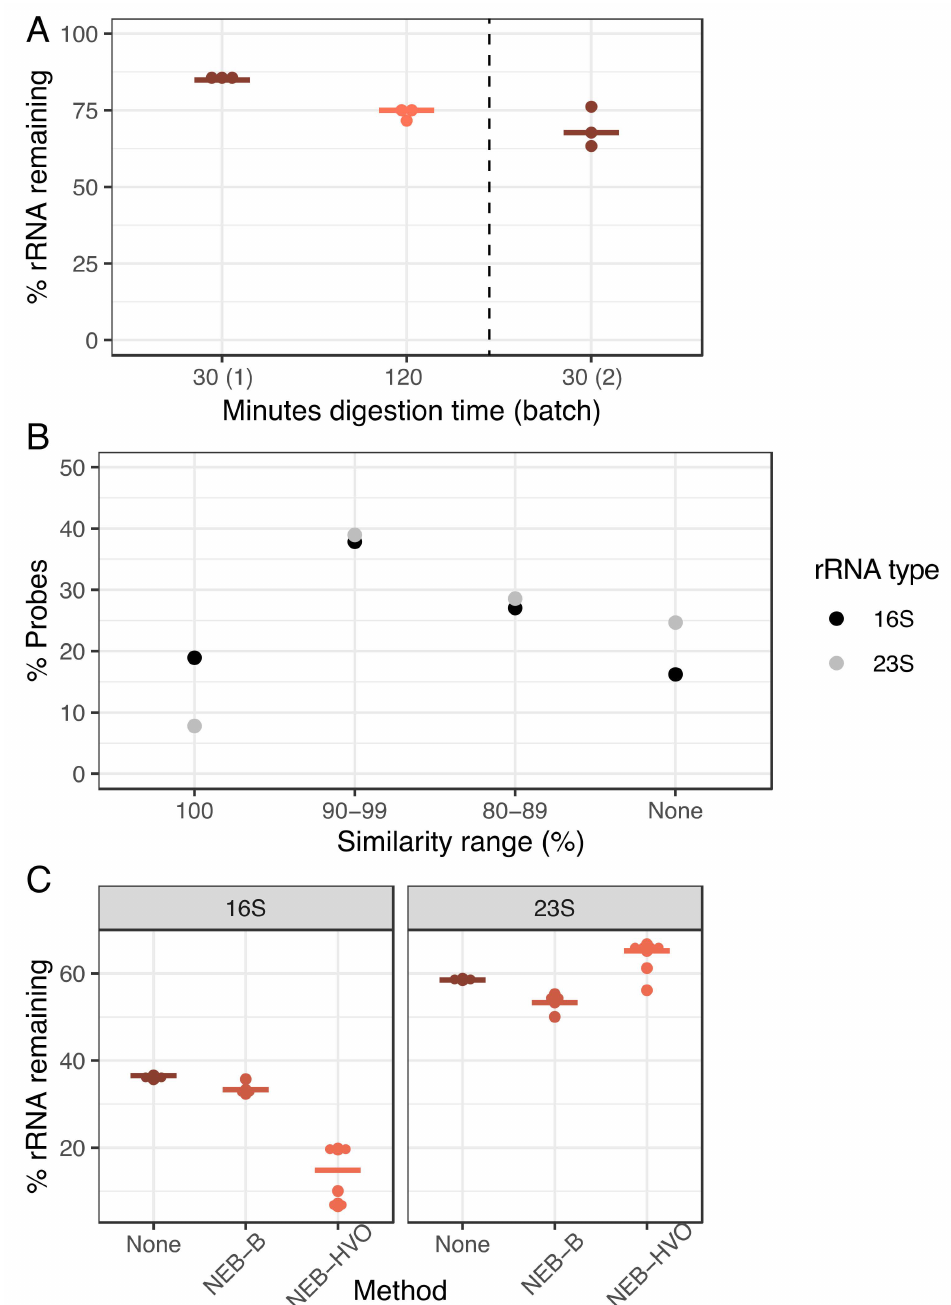
Figure 4. Increasing RNAse digestion time is less important than probe sequence identity for efficient rRNA removal. ( A ) Dotplot showing percentage of counts mapping to rRNA genes after using the NEB-HVO method on HBT total RNA samples after 30 min (brown) or minutes 120 (light orange) of RNAseH digestion. “NEB30 (2)” samples to the right of the dotted line were processed and sequenced in a different batch. Horizontal bars represent the median value. ( B ) Percentage of custom-designed HVO probes classified into 16S (black) and 23S (grey). Levels of sequence identity of HVO probes with Hbt. salinarum (HBT) 16S and 23S rRNA genes are shown on the X-axis, whereas the percentage of total probes at each sequence identity level is shown on the Y-axis. ( C ) Percentage of total reads mapping to either 16S (left panel) or 23S rRNA (right panel) genes of HBT using three different rRNA removal method—none (brown), NEB-B (dark orange), and NEB-HVO (light